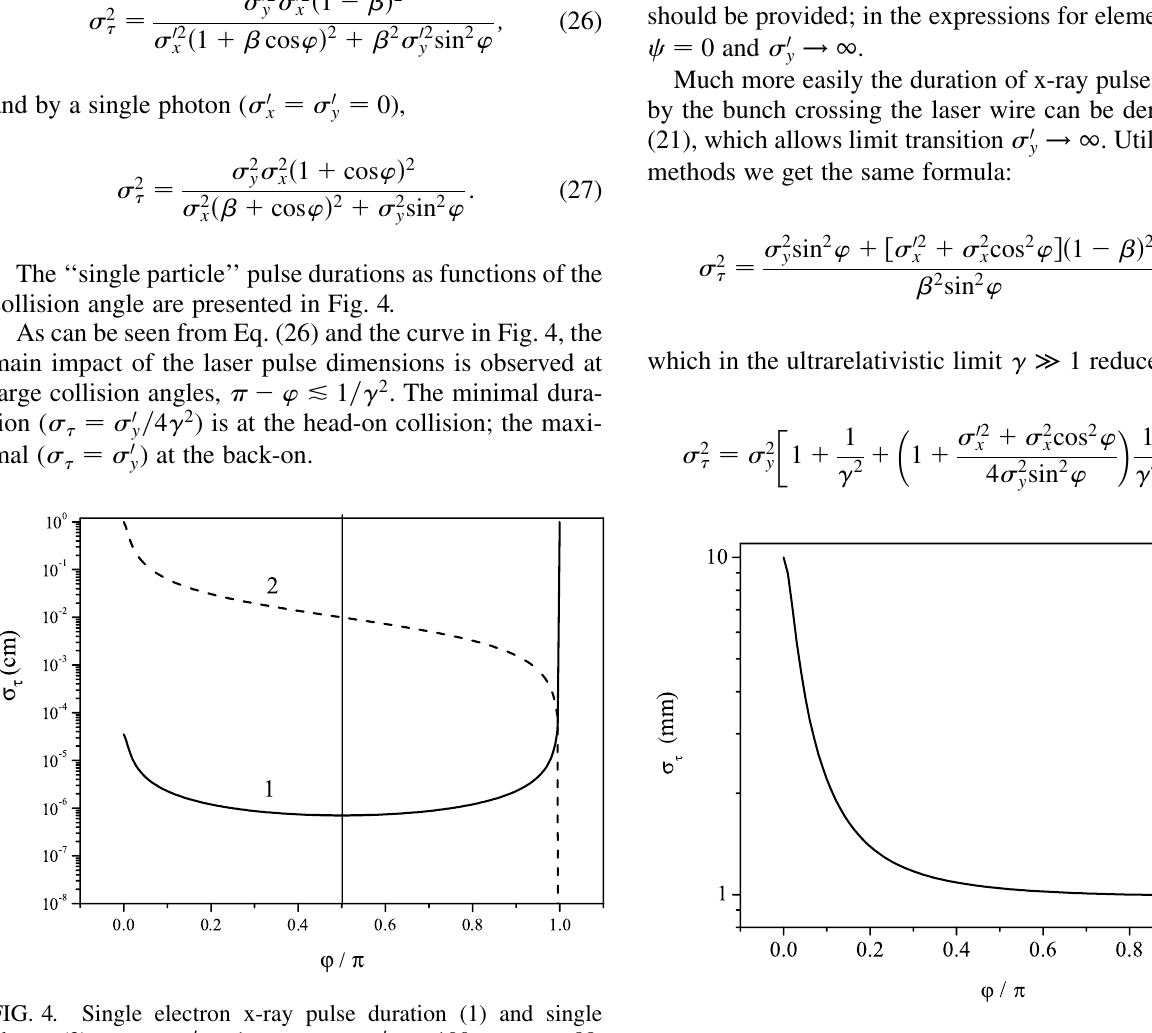
FIG. 5. Backscattered x-ray quanta pulse